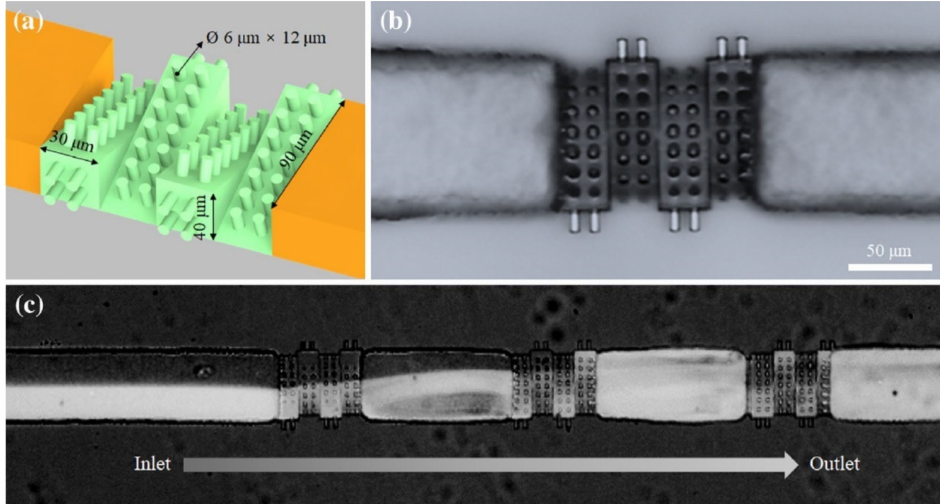
Figure 5. A passive mixer fabricated by MPL incorporated into a microfluidic platform. ( a ) Schematic illustration the four triangular blocks used as the mixer replica. ( b ) The replicated PDMS device. ( c ) Successful mixing of two liquids (fluorescein sodium salt and DI water) by using the passive mixer. Reprinted from Ref. [71] by permission from Springer Nature: Springer-Verlag GmbH, Microfluidics and Nanofluidics Copyright 2018.